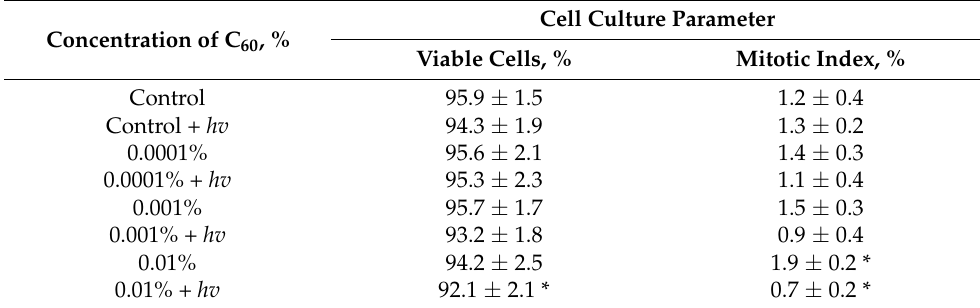
Table 1. The effect of a colloidal solution of C 60 on the growth and development of eukaryotic cells. Concentration of C 60 ,